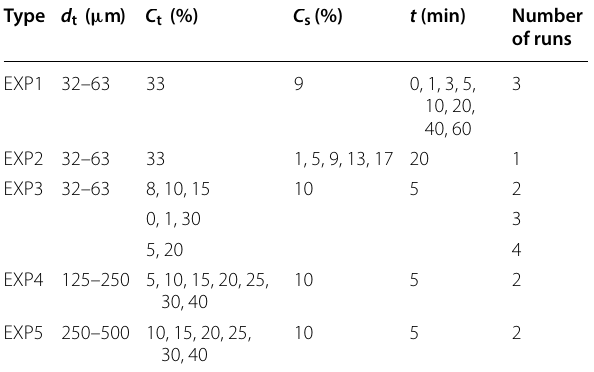
Table 1 List of experimental conditions Type d t ( µ m ) C t (%)